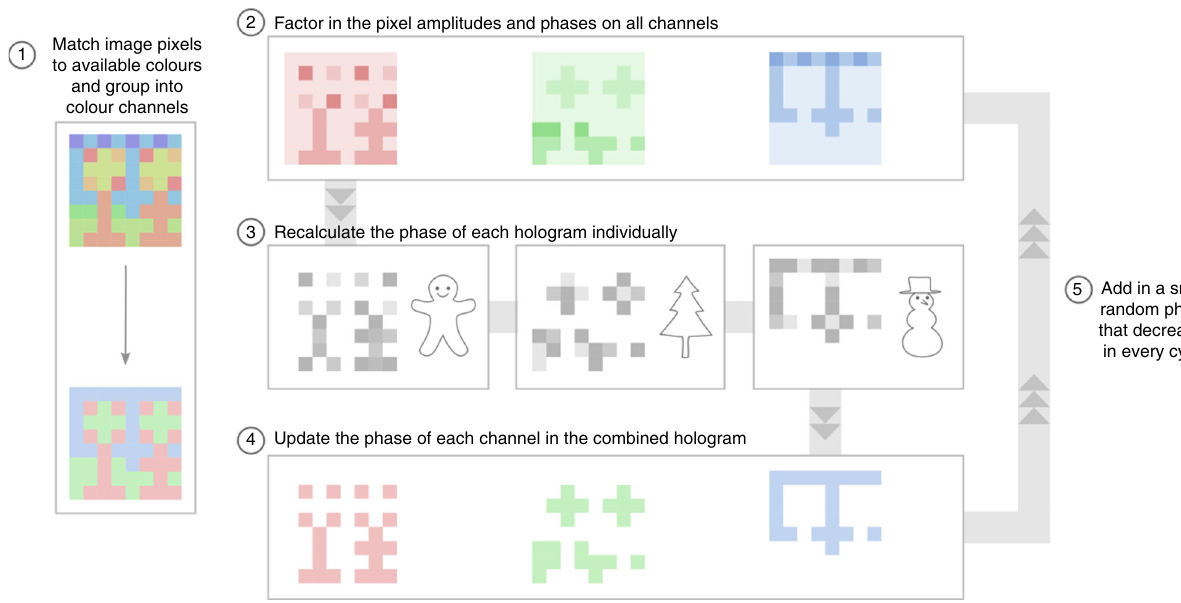
Fig. 5 Design algorithm for holographic colour prints. Flowchart of the design algorithm for combining colour image formation and spatial multiplexing of holograms. The initial stage of the algorithm (Step 1) recolours the input colour image using a limited colour palette and then divides the colour pixels into several groups (channels) based on their suitability for fi ltering each hologram. After the assignment in Step 1, the main body of the algorithm (Steps 2 – 5) applies a modi fi ed Gerchberg – Saxton algorithm that takes into account the arrangement of pixels as well as their amplitudes (transmission spectra) and phases in order to iteratively re-optimise the phase of the holograms on each channel. Despite the imperfect selectivity of the pixel amplitudes (there is non-zero transmission at unwanted wavelengths, which results in crosstalk between channels), a satisfactory balance between the quality of the colour image and holographic projections can be achieved by using a suf fi ciently large number of pixels, which allows for both spatial (as exempli fi ed by Fig. 3) and spectral (as in Fig. 4) degrees of freedom to be exploited